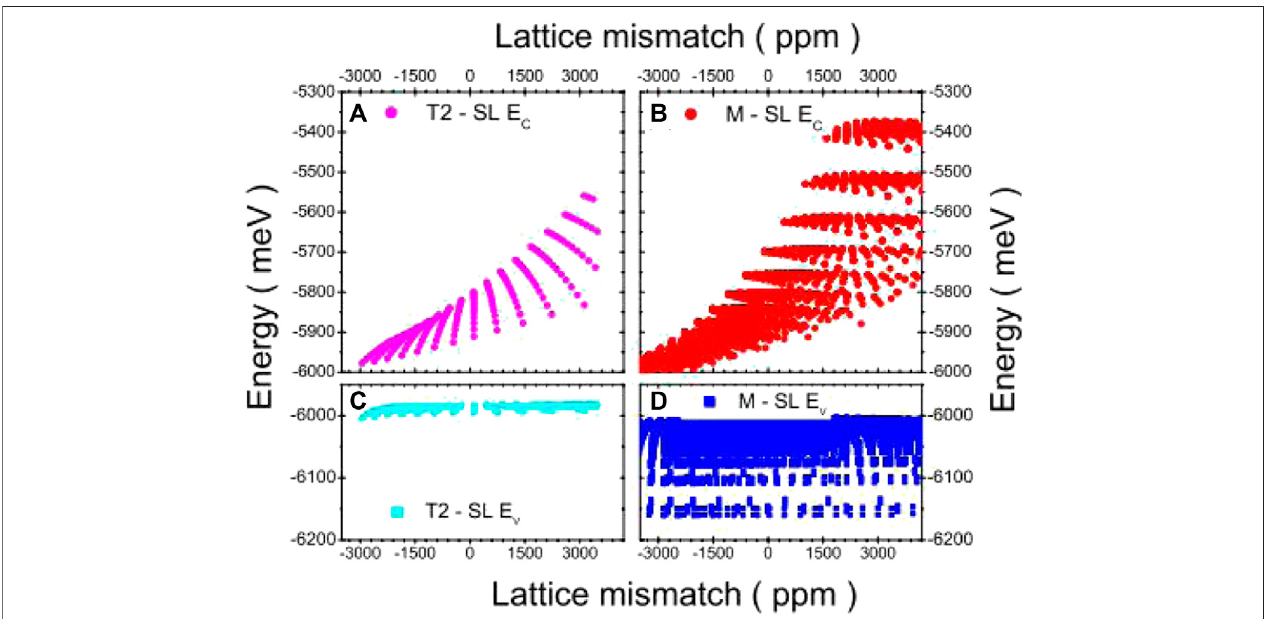
FIGURE 10 | Energy distributions of various SL designs: (A) type II InAs/GaSb conduction band ( (cid:129) ), (B) M-type structure conduction band ( (cid:129) ), (C) type II InAs/GaSb valence band (light blue squares), and (D) M-type structure valence band (dark blue squares). The M-type structure exhibits a larger bandwidth.